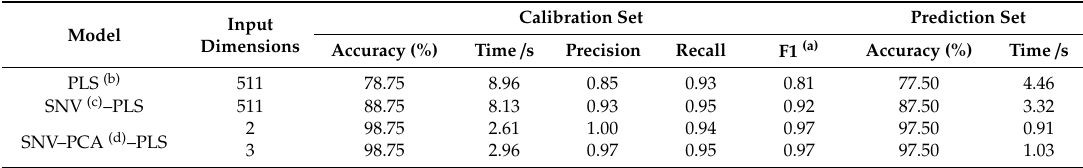
Table 3. Comparison of classification model